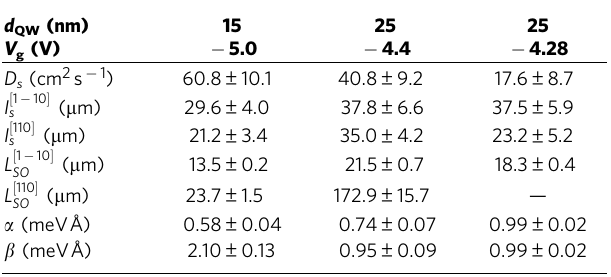
Table 1 | Spin-related parameters obtained from the experiments.